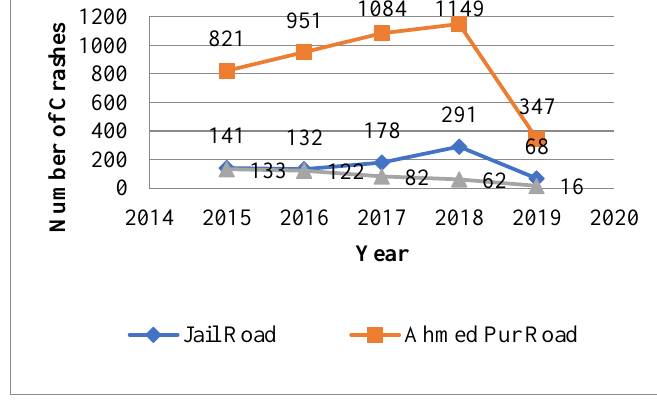
Fig. 6. Crash trend